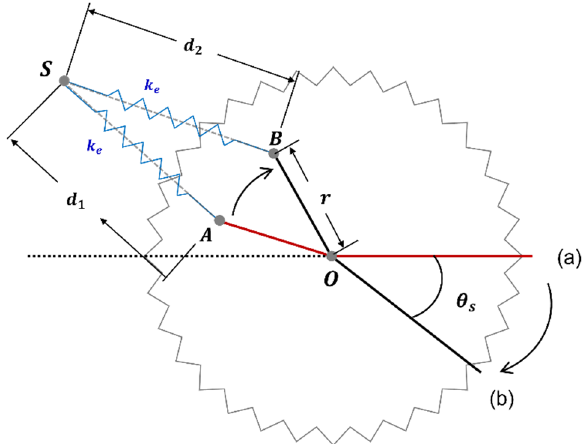
Figure 3. The motion of the extension spring with the spur gear movement.